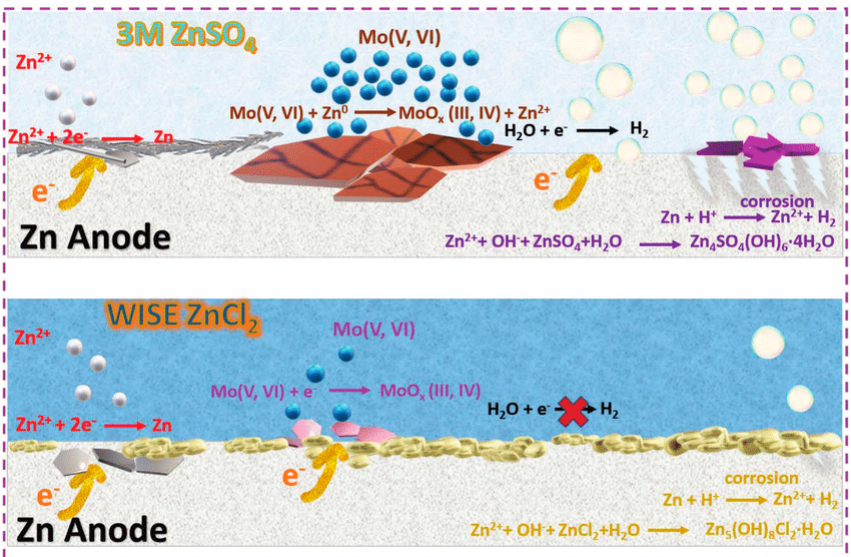
Figure 3. Schematic showing the plausible reaction mechanisms at both MoO 3 cathode and Zn anode in the 3 M ZnSO 4 and 30 M ZnCl 2 WISE. Reproduced with permissions from Ref. [54]. Copyright © 2021 WILEY-VCH.